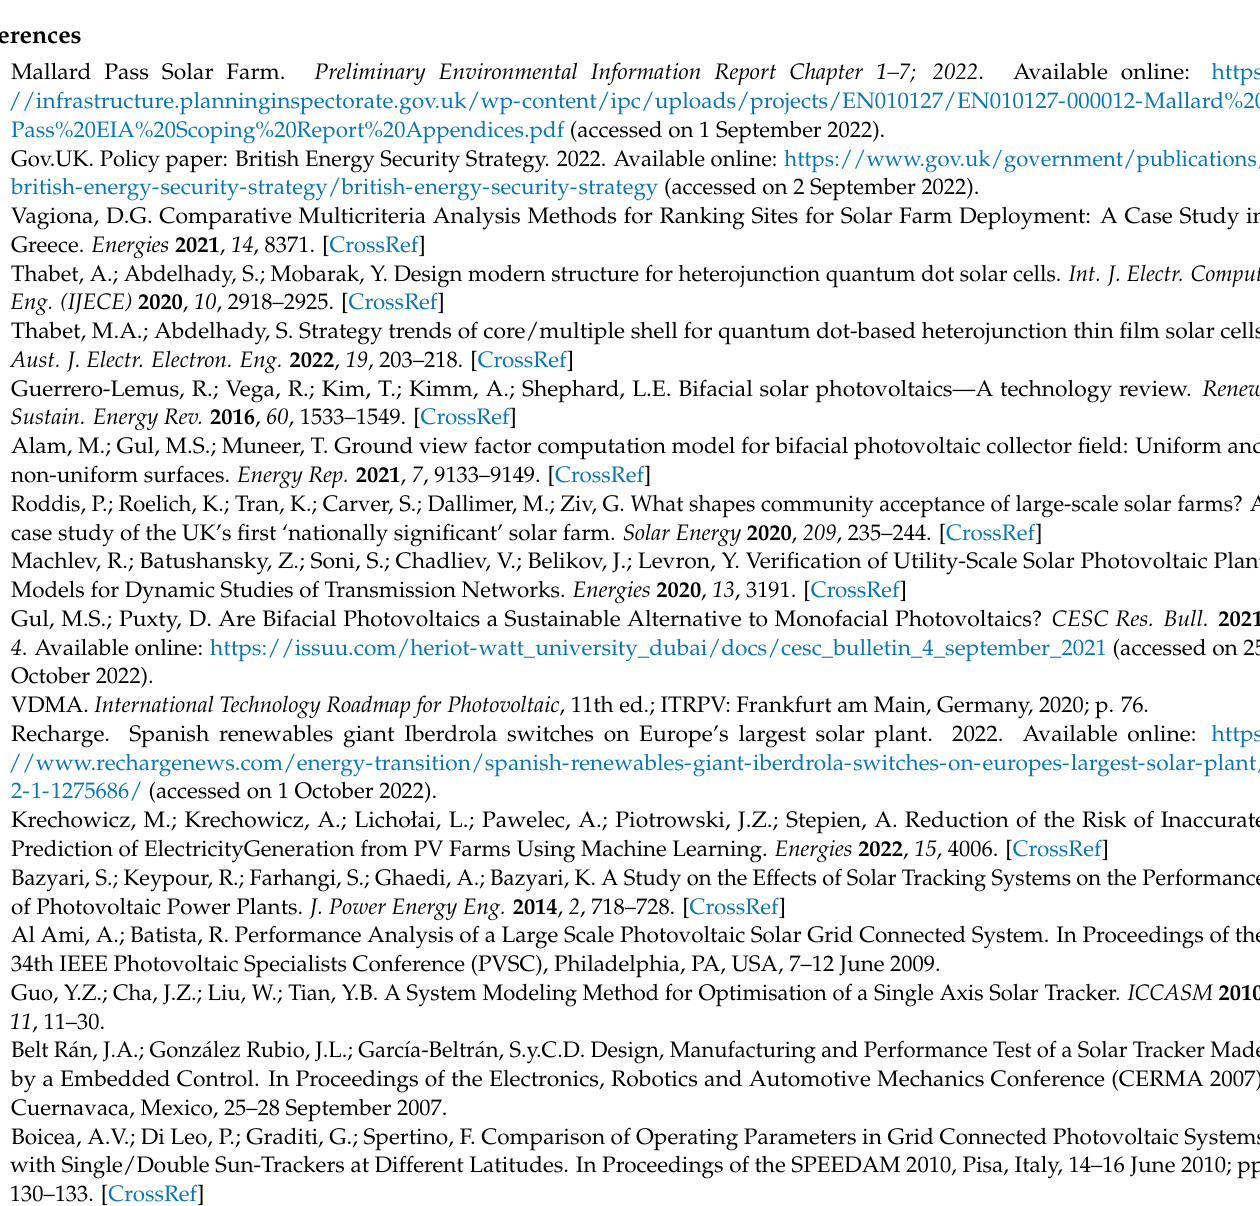
Figure A1. Configuration of two PV modules (half module shown as 4′ and 4″) and the supporting stand (shown as 4). The foreground is represented by areas 1 and 2. Dimensions: a1 = 1.42, a2 = 2, a3 = 2, b = 4, c1 = 0.5 and c2 = 4.5. All dimensions are in metres. The chosen PV module had P max, STC = 410 W and dimensions of 2 × 1 m.